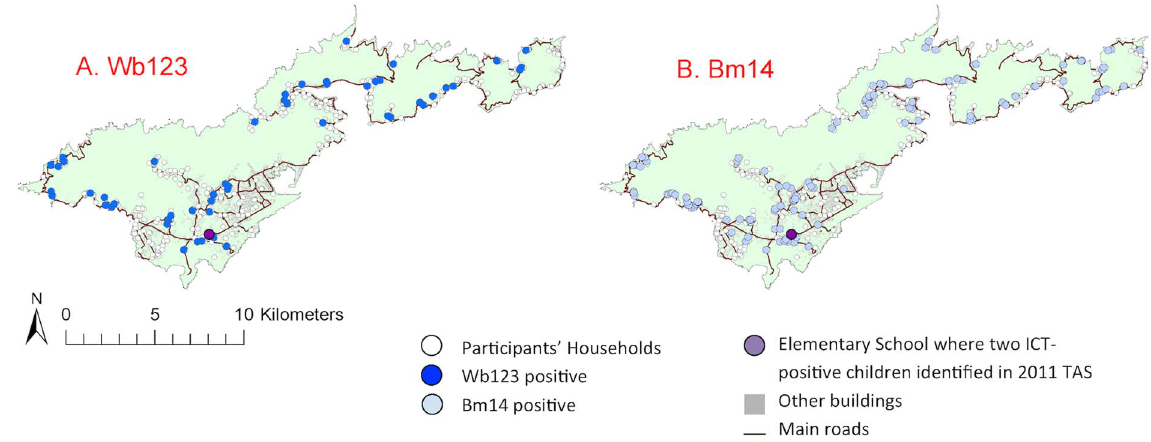
Figure 4. Household locations of individuals with positive and negative antibodies on Tutuila. A. Wb123, B. Bm14.